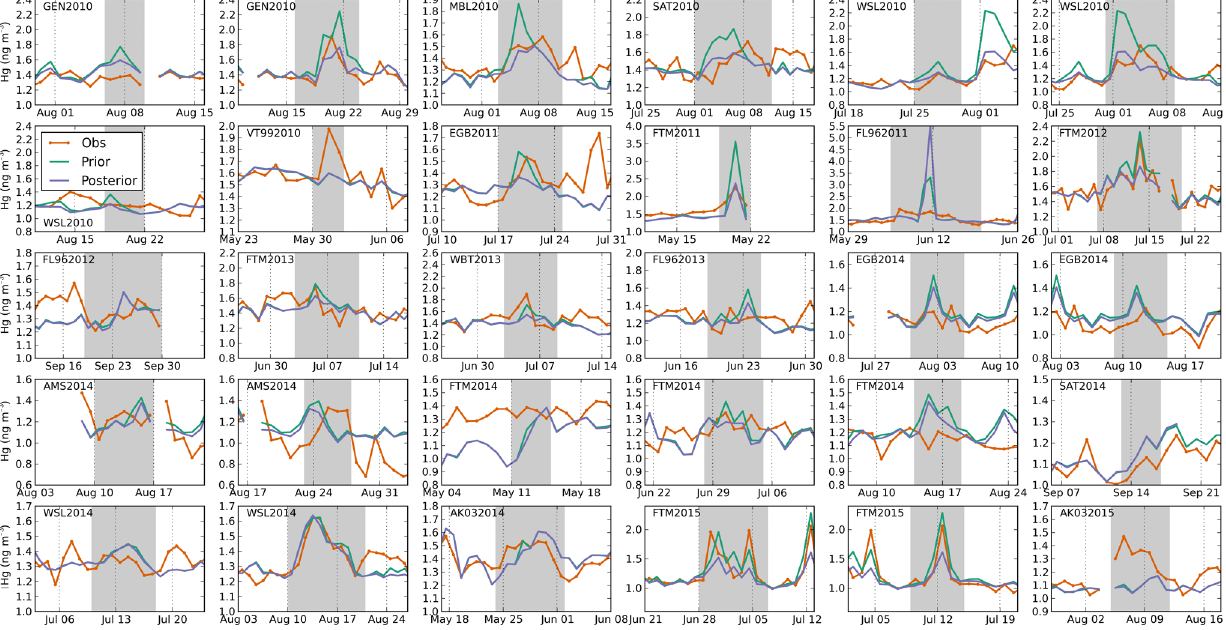
Figure 2. Daily GEM concentrations from observations and model with prior and posterior emission factors for all 30 fire plumes. The model concentrations have been corrected for the bias between the model and the observations. The shaded area indicates the time period designated as the fire plume event. Note the different y